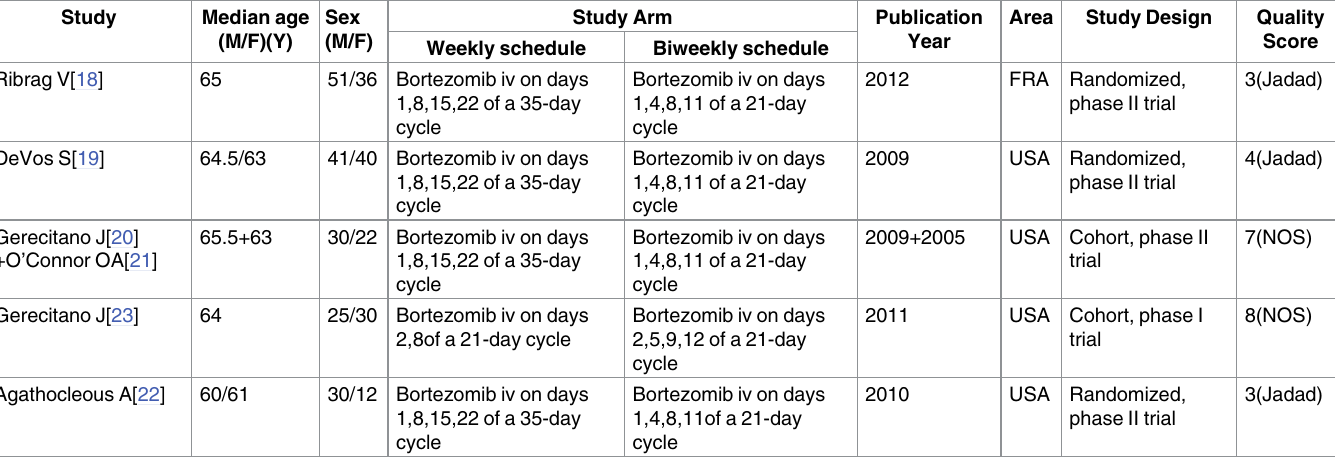
Table 1. The characteristics of 6 trials.